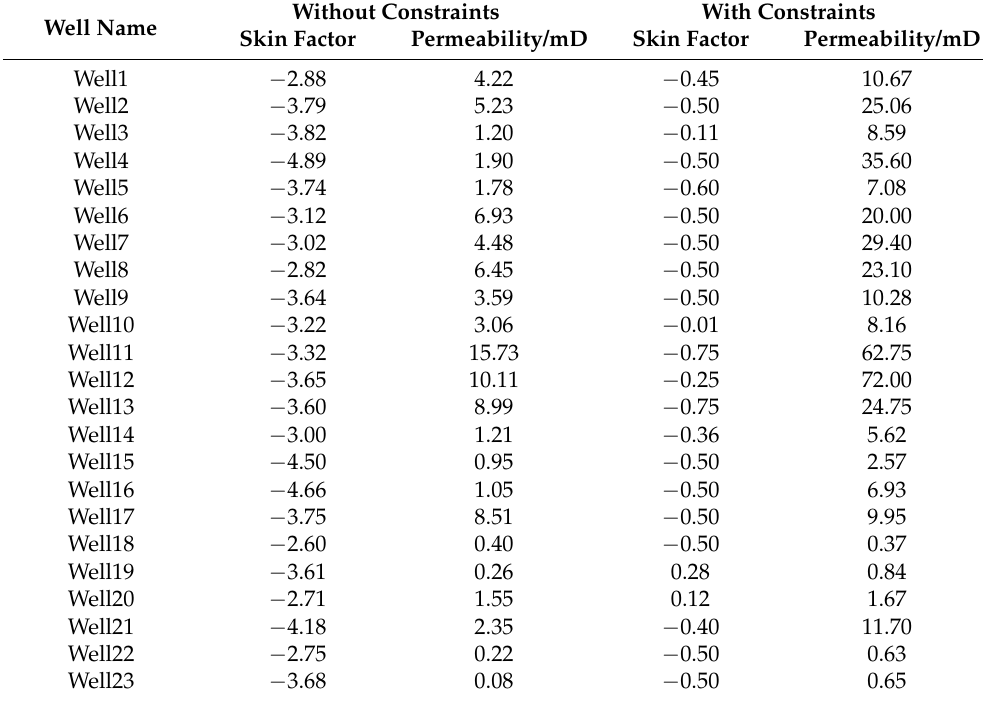
Table 1. Interpretation results for the transient pressure with and without skin factor constraints.